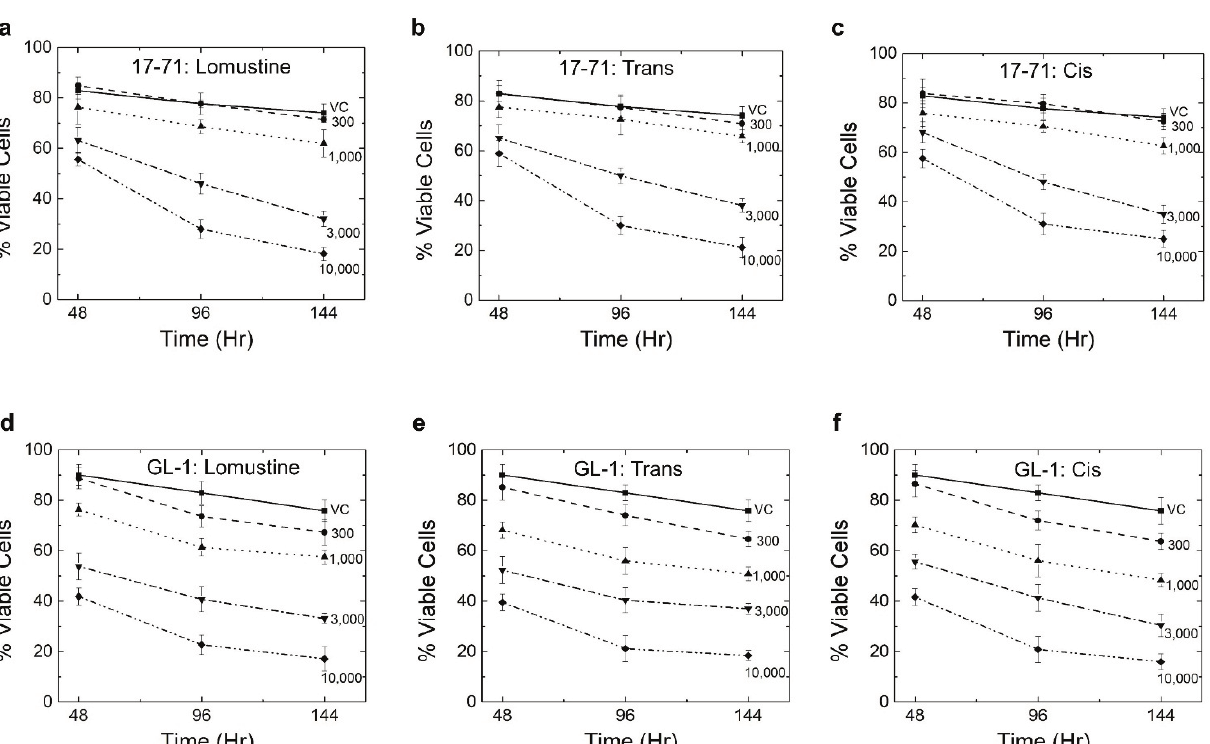
Figure 6. Graphs showing the results of Annexin/PI assay in 17–71 cells ( a , b and c ) and GL-1 cells ( d , e , and f ) at 48, 96 and 144 h after treatment with lomustine, trans- and cis-4-hydroxylomustine. Vehicle control (VC) was 0.1% methanol. The results show the mean and standard deviation of three independent experiments (n =